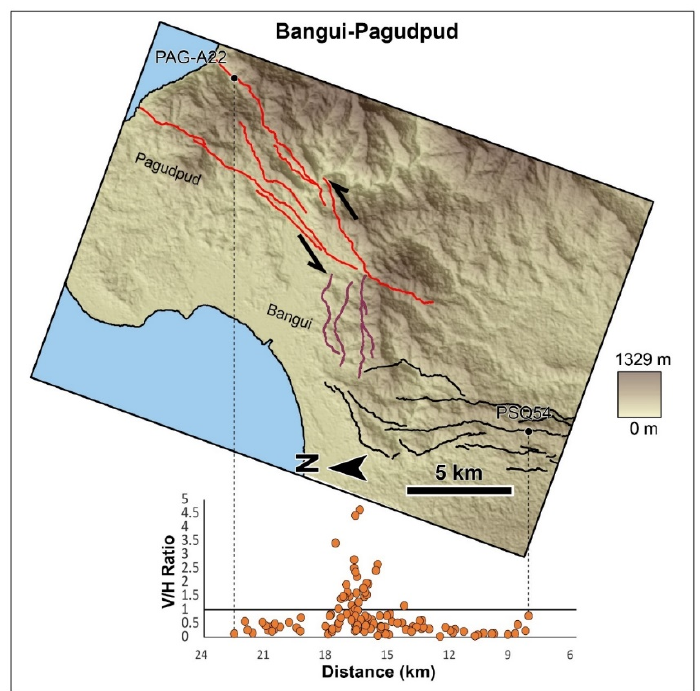
Figure 13. Map of the trace from south of Bangui to Pagudpud (labelled ‘g’ in Figure 2A) above the offset plot for this part of the Vigan-Aggao Fault. The fault zone is also marked by bends and right-step gaps. The Bangui-Pagudpud segment is traced in red, while the northern portion of the Bacarra-Burgos segment is traced in black. The transition between segments is traced in violet.